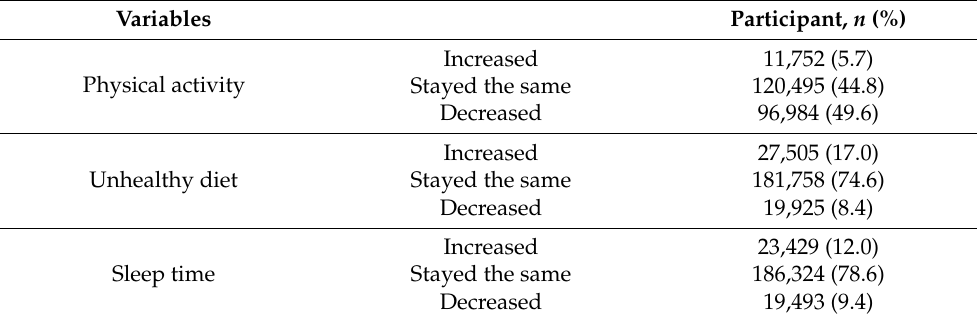
Table 2. Changes in physical activity, diet, and sleep time during the COVID-19 pandemic in South Korea.